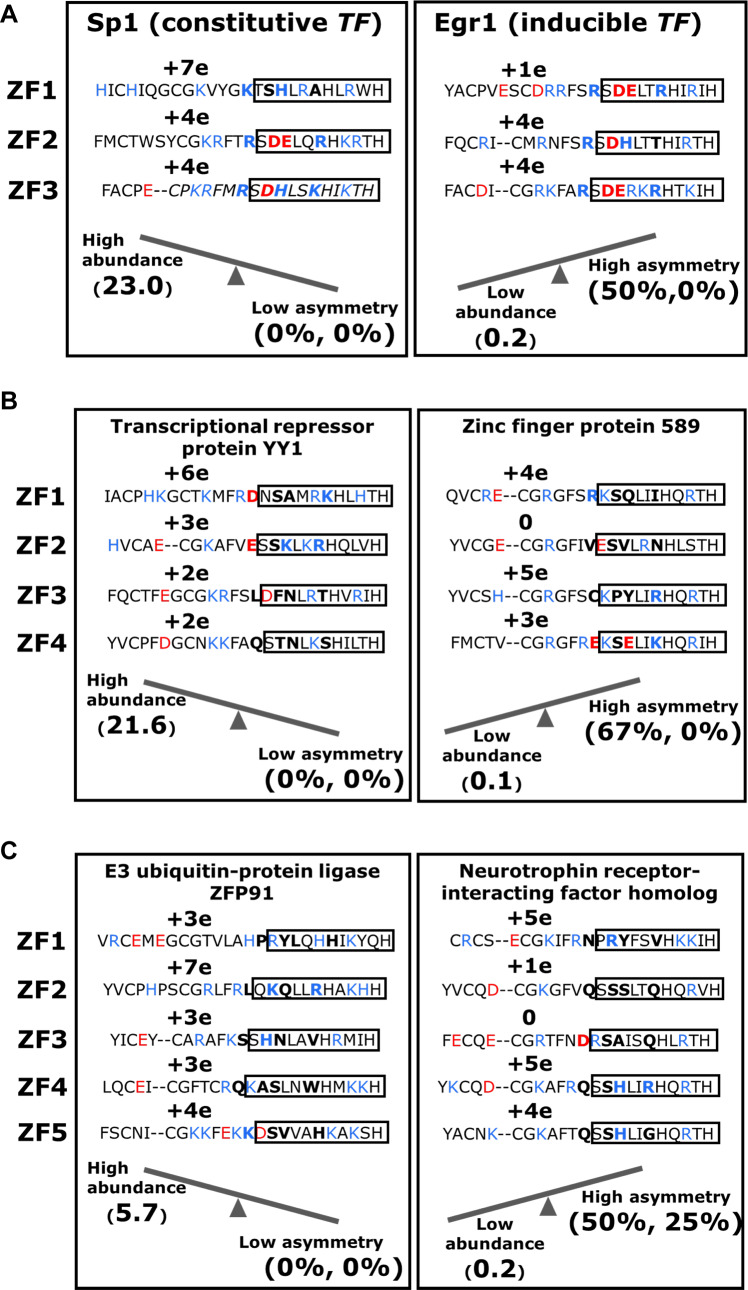
Examples of C2H2-type zinc-finger proteins with low (left side of each panel) and high (right side of each panel) asymmetry. (A) The amino-acid sequences and net charges of the three zinc-finger domains of the constitutive transcription factor Sp1 (left) and the inducible transcription factor Egr-1 (right). The amino-acid sequence is shown for each zinc finger domain (as identified at the left of the box), with the net charge of each domain shown immediately above it. In the sequence, positively and negatively charged residues are coloured in blue and red, respectively, and shown in bold. The recognition helix sequences are enclosed in a box. The positions (-1, +2, +3 and +6) of the four residues involved in specific DNA binding are shown in bold. With respect to the net charge, a pair of adjacent zinc finger domains is considered electrostatically asymmetric if it bears a negative net charge (<2e) and/or if the difference in net charge between the two members of the pair is ≥3e. If all pairs of adjacent domains fail these criteria, then the electrostatic asymmetry of the zinc finger protein is 0%. At the bottom of each box, the abundance and the percent asymmetry values are given at the left and right ends, respectively, of the see-saw, which represents their relationship (i.e. negative correlation). The two asymmetry percentages shown refer to non-specific binding and specific binding, respectively. Panels (B) and (C) show examples for 4-domain and 5-domain zinc finger proteins, respectively.